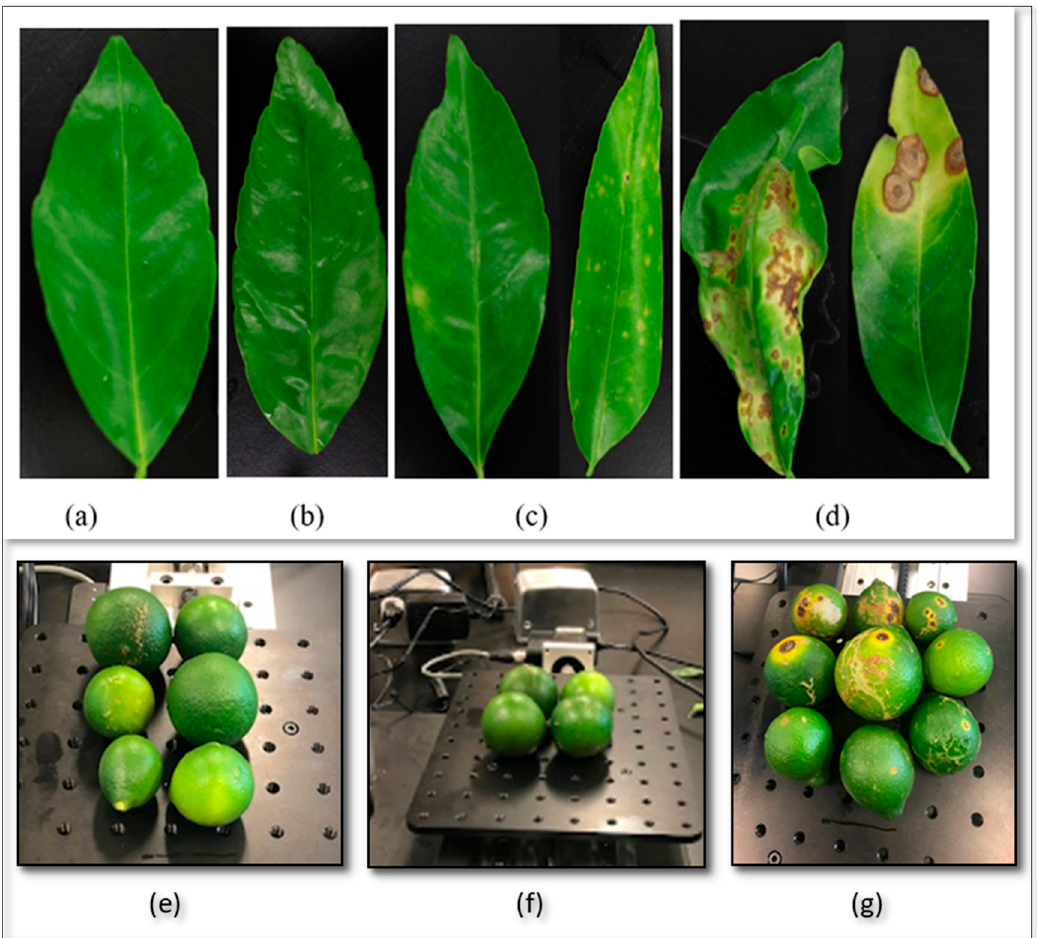
Figure 1. Example of Sugar Belle leaves (upper panel) representing four categories: ( a ) healthy; ( b ) asymptomatic; ( c ) early, and ( d ) leaves with late canker developmental stages. Lower panel is examples of Sugar Belle immature (green) fruits representing three categories: ( e ) non-infected; ( f ) asymptomatic, and ( g ) fruits with late canker developmental stages.